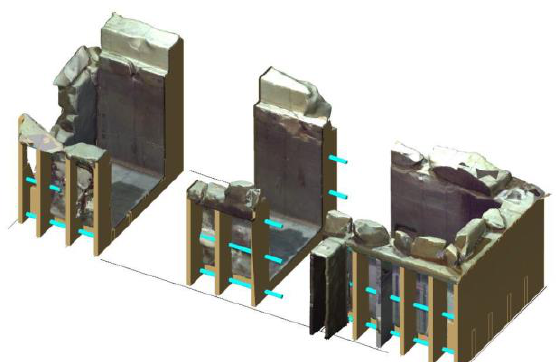
Figure 18: The tomb of Ipi. Sarcophagus. 1:1 Scale proposal. 2 x 1.5 x 1.2 m.,